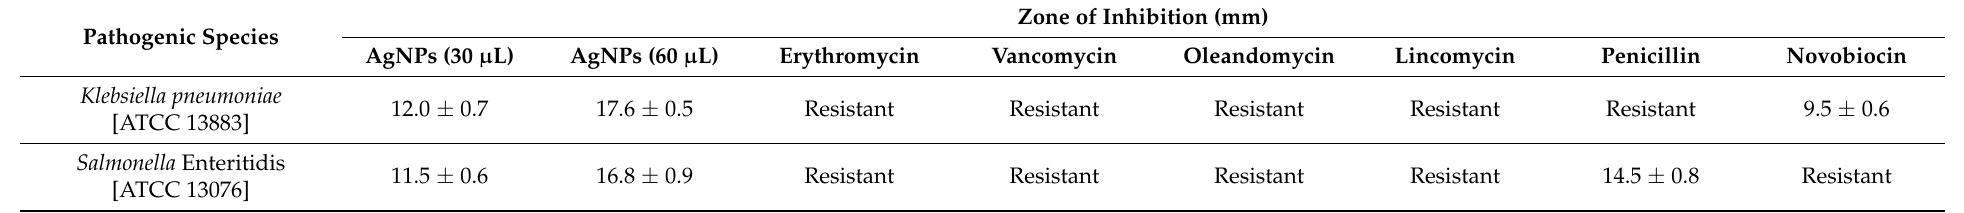
Table 2. Antibacterial efficacy of Massilia sp. MAHUQ-52 mediated synthesized AgNPs and certain commercial antibiotics against K. pneumoniae and S.